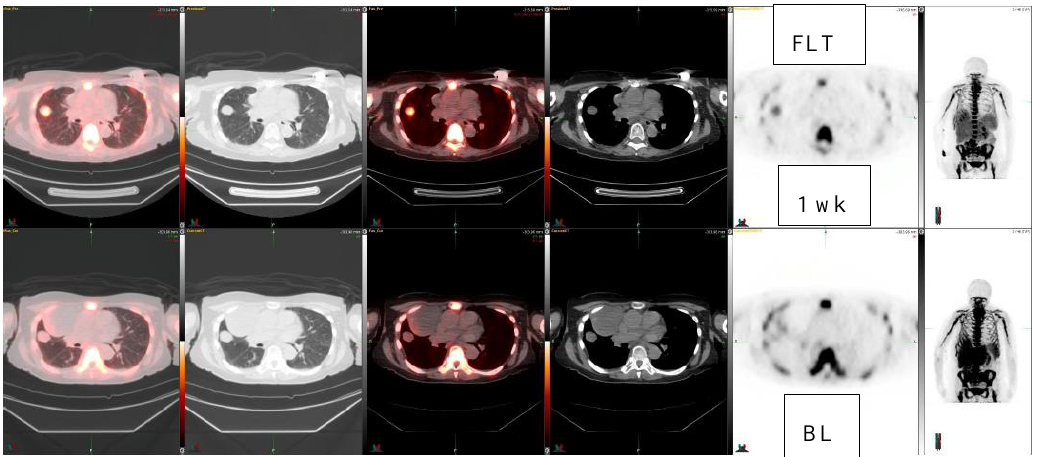
Figure 4. Fibrous tumor, pleura. FLT-study at baseline and at 1 week (2 rows) demonstrates decrease (−43%) in the lung mass: FLT: SUVmax 3.0 ->1.7. On CT it becomes slightly bigger, CT: 2.4 cm × 1.9 cm ->2.5cm × 2.0 cm.